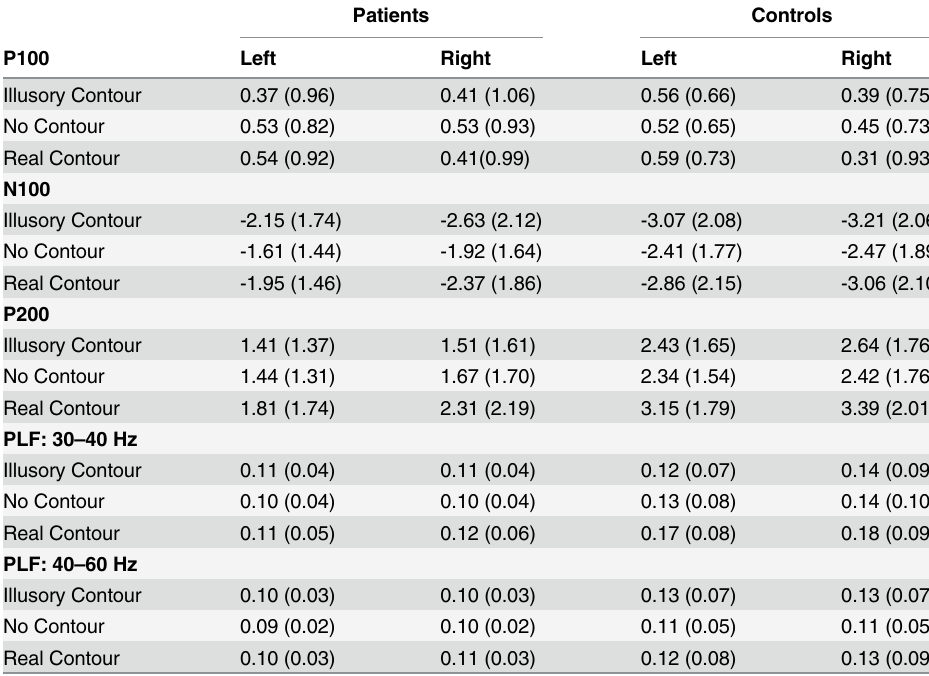
Table 3. Mean (SD) ERP amplitudes and phase locking factor (PLF) values for patients and controls for illusory, no contour, and real fi gures.